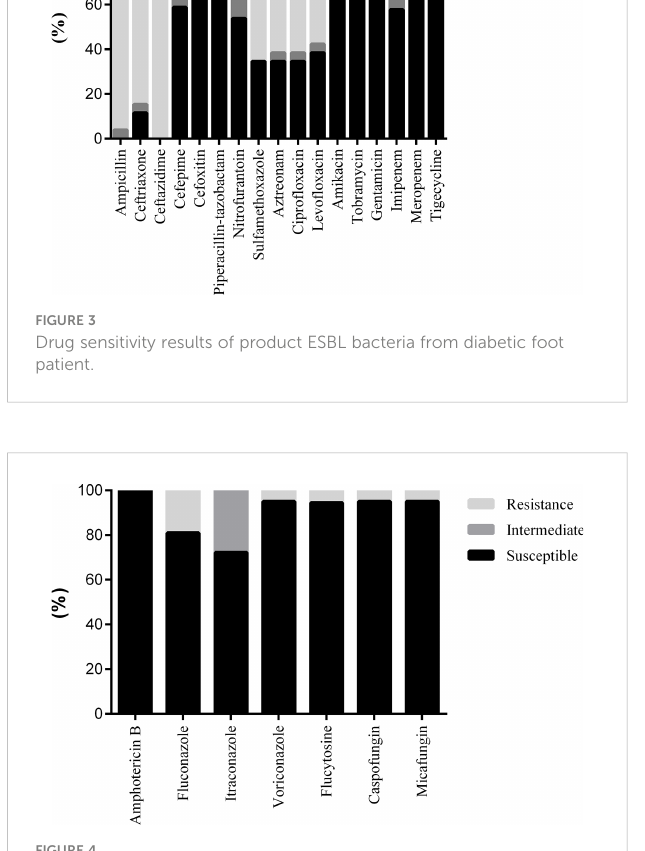
FIGURE 4 Drug sensitivity results of Fungus from diabetic foot